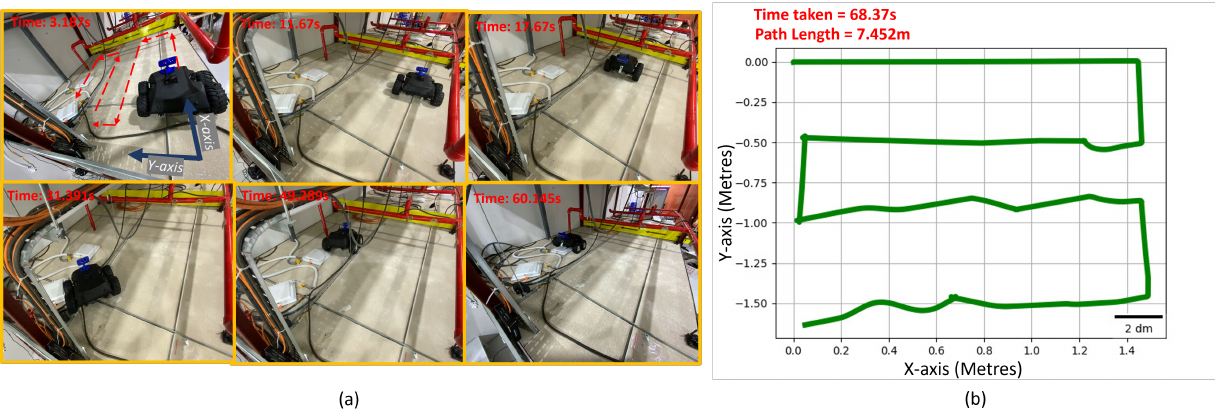
Figure 15. The experiment trial performed in the false-ceiling test-bed for covering 2 × 2 m. ( a ) Robot performing inspection in the false-ceiling test-bed at various time frames. ( b ) Fused odometry plot of robot during experimental